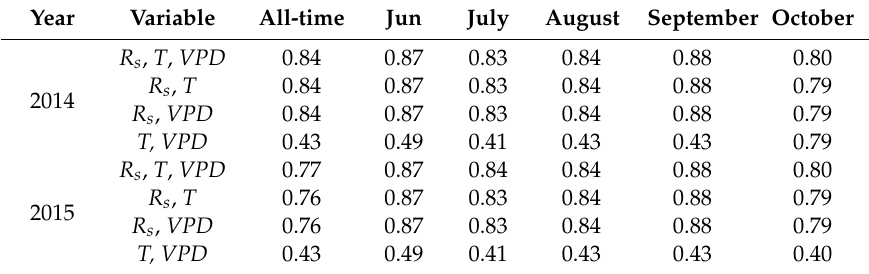
Figure 3. Half hourly stand transpiration against solar radiation ( R s ), air temperature ( T ), and vapor pressure deficit ( VPD ) during the growing season in ( a – c ) 2014 and ( d – f ) 2015. Table 4. Determination coefficient ( R 2 ) of the seasonal bivariate and trivariate stepwise regression models in which stand transpiration is the dependent variable and solar radiation ( R s ), air temperature ( T ), and vapor pressure deficit ( VPD ) are independent variables.